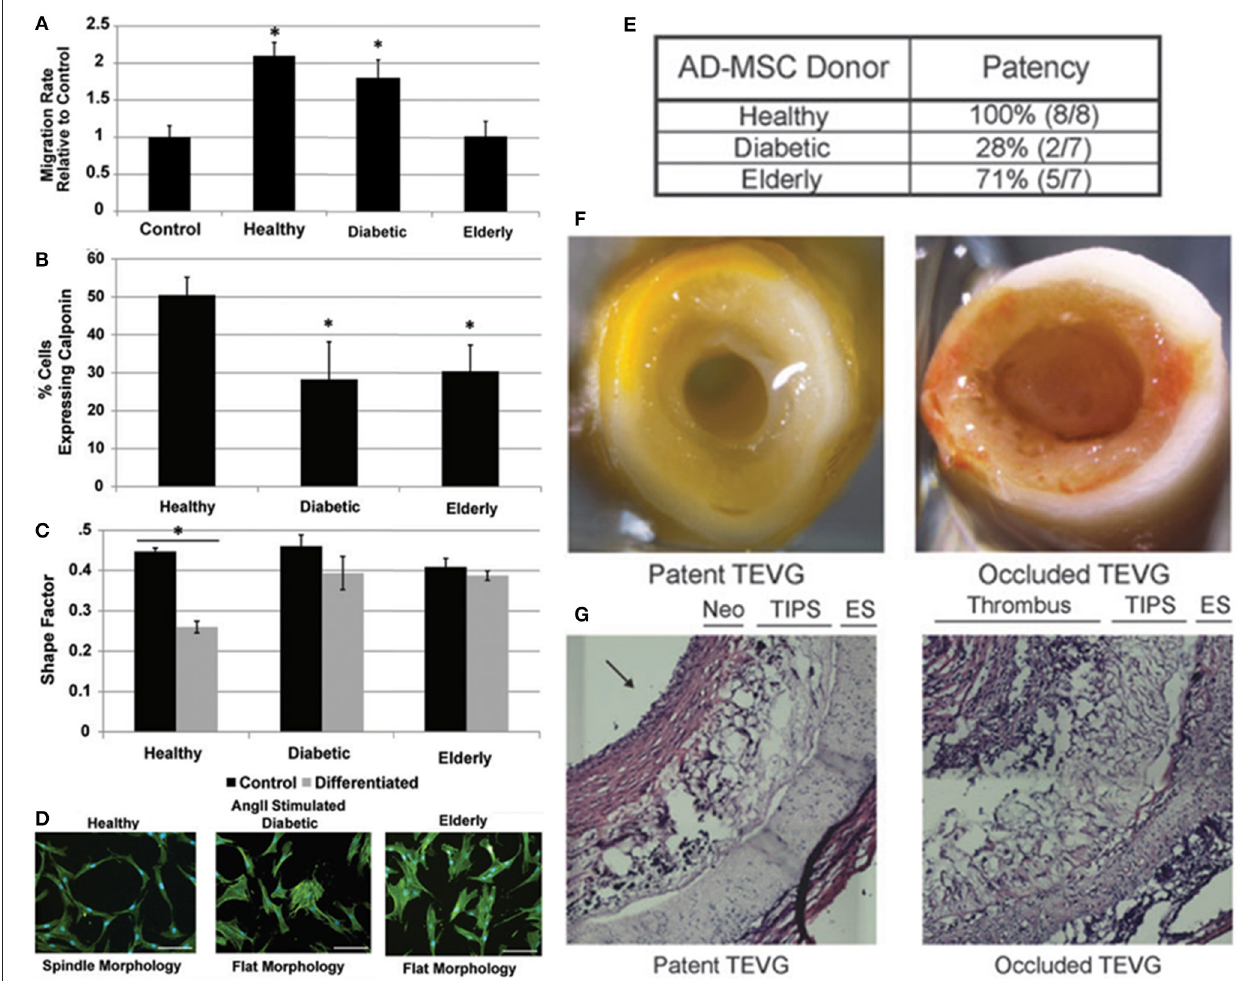
FIGURE 2 | Combination of in vitro and in vivo studies that demonstrate the diminished regenerative potential of stem cells in vascular tissue engineering when harvested from elderly or diabetic patients. (A–D) The ability of ADMSCs from elderly or diabetic patients to encourage smooth muscle cell migration and secrete factors that promote fibrinolysis is decreased ( 48, 59). (E–G) The ability of ADMSCs to prevent acute thrombosis and encourage remodeling when seeded on a PEUU scaffold implanted in a murine model is reduced when harvested from elderly or diabetic patient groups ( 48). Adapted from Krawiec et al. (48, 59) with permission from Mary Ann Liebert,